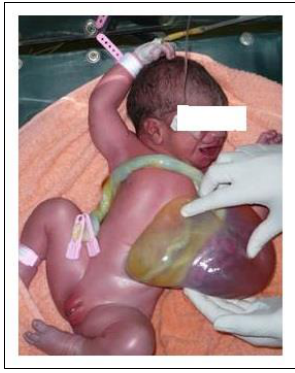
Figure 3: Large HUC containing many loops of bowel mimicking as giant omphalocele. The child was cyanotic and had cardiac anomalies.